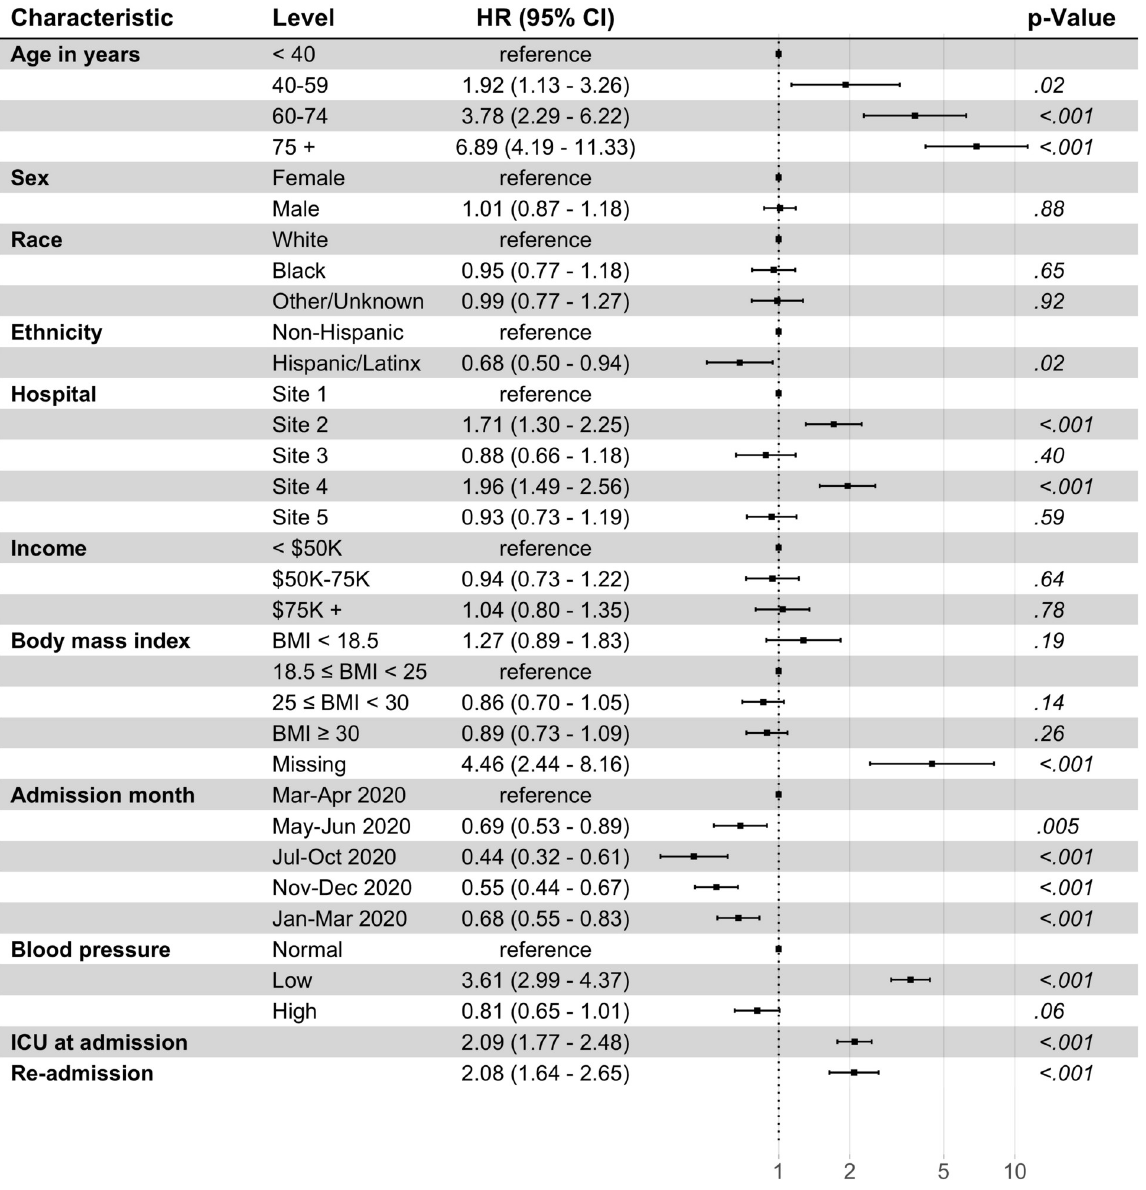
Fig 2. Multi-state multivariable Cox regression model for hospitalization to death transition (model 1). N = 6233; 22 observations deleted due to missingness in zip code (15) and blood pressure (7). Site 1 (n = 1762), Site 2 (n = 1048), Site 3 (n = 1030), Site 4 (n = 1163), Site 5 (n = 1252) are unique hospitals in the University of Pennsylvania Health System. Blood pressure, classified as low if systolic blood pressure (SBP) < 90 millimeters of mercury (mm Hg) or diastolic blood pressure (DBP) < 60 mm Hg; otherwise, classified as high blood pressure if SBP > 130 mm Hg or DBP > 80 mm Hg; CI: Confidence interval; ICU, intensive care unit; Income, Median household Income in patient’s 5-digit zip code, as determined by the 2014–2018 5-year American Community Survey (ACS); HR, hazard